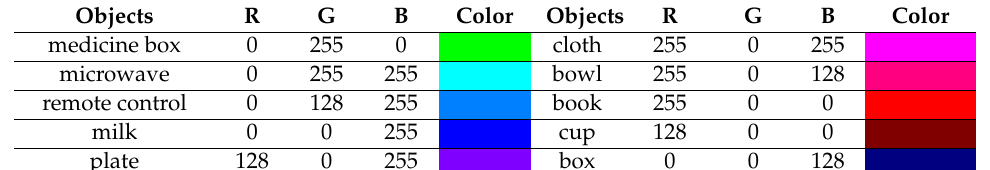
Table 3. Color representation of each object category in the CAD-120 dataset.